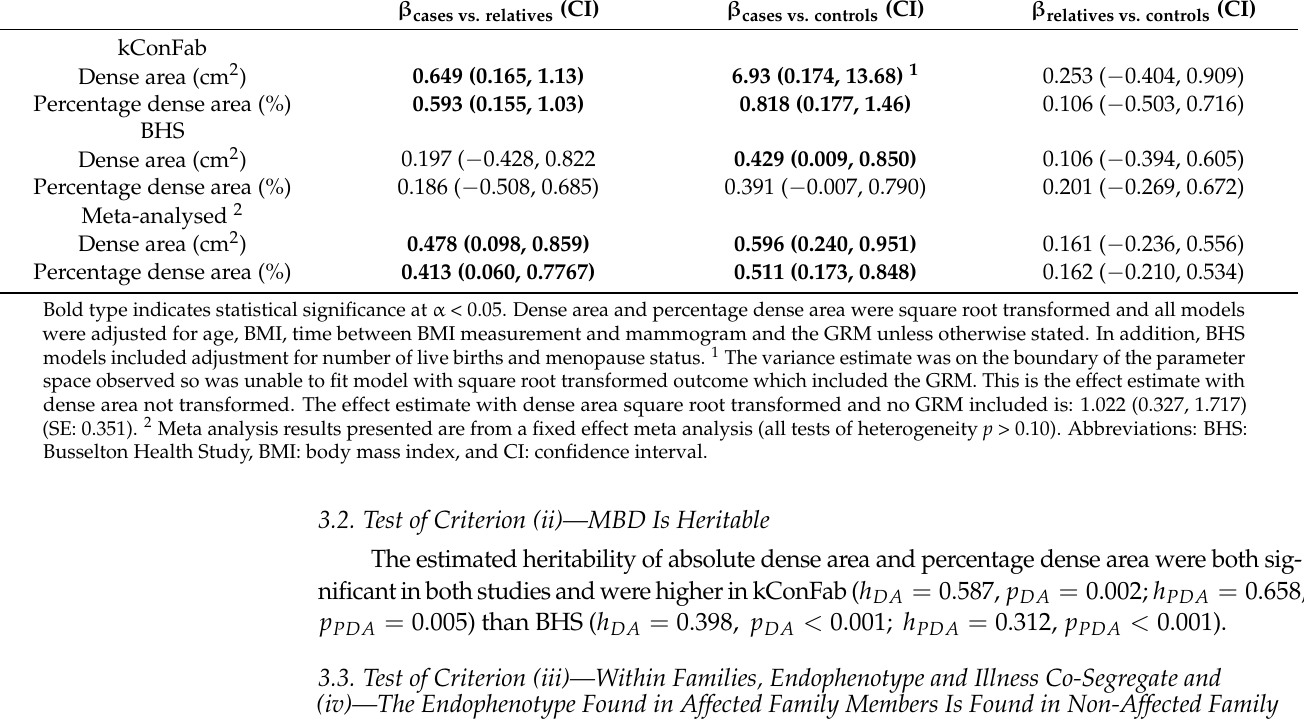
β cases vs. relatives (CI)